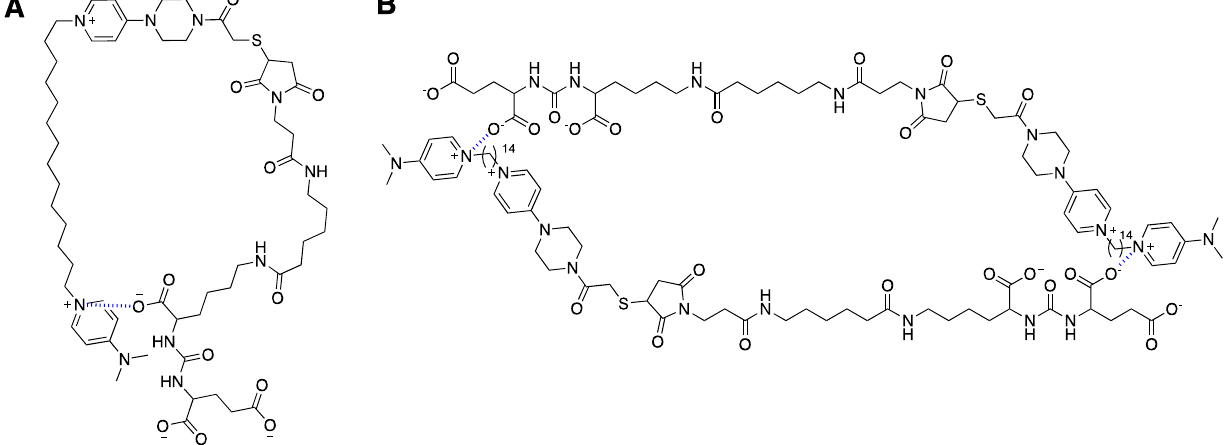
Figure 10. Proposed ( A ) intramolecular and ( B ) intermolecular electrostatic interactions (blue dashed line) for CK147 which inhibit activity towards the PSMA receptor and CHKA.